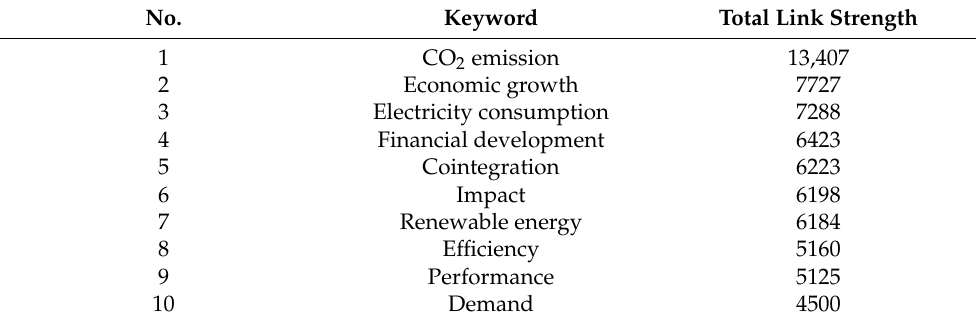
Table 1. The TOP-10 co-occurrence keywords in the papers concerning energy consumption. No. Keyword Total Link